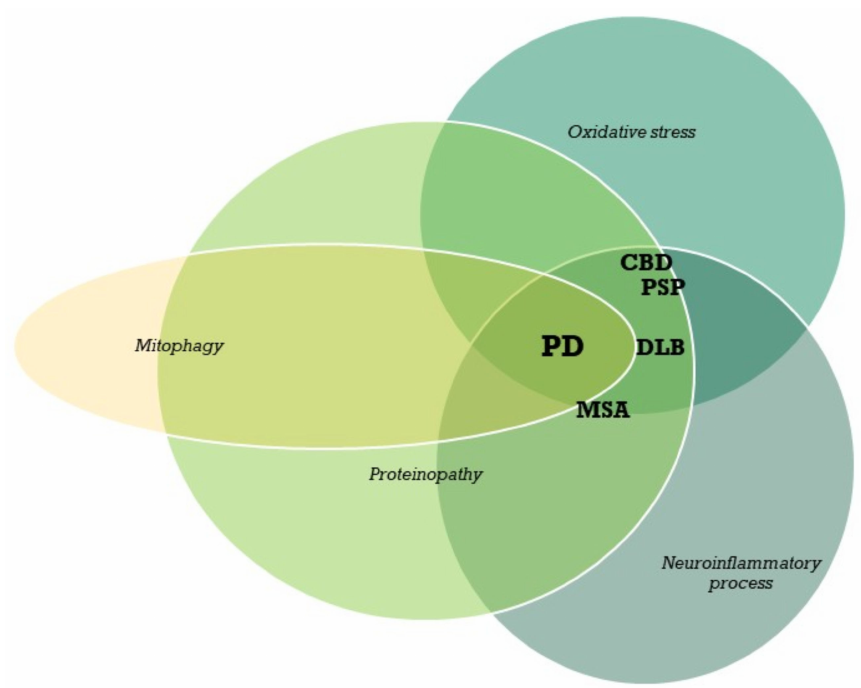
Figure 1. Coexistence of different mechanisms of neurodegeneration in parkinsonism. PD— Parkinson’s disease; CBD—corticobasal degeneration; PSP—progressive supranuclear palsy; MSA— multiple system atrophy; DLB—dementia with Lewy